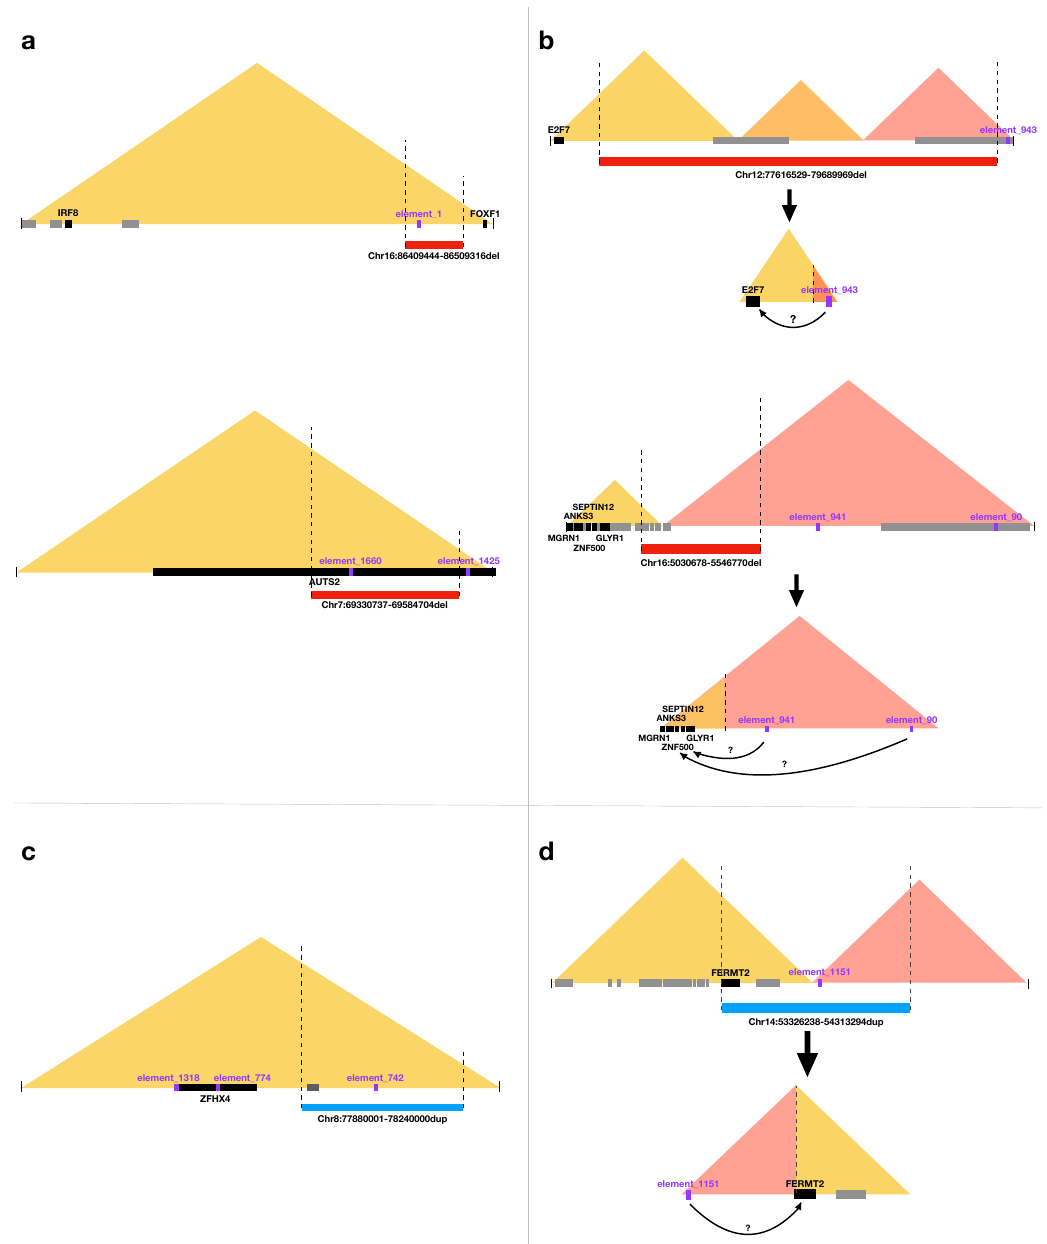
Figure 2. Schematic representation of the intraTAD deletions ( a ), interTAD deletions ( b ), intraTAD duplications ( c ), and interTAD duplications ( d ), potentially altering gene-enhancer interactions relevant for the congenital heart defects (CHD). The deletions are shown as red bars. The duplications are shown as blue bars. The triangles reflect the topologically associated domain (TAD) structure of the locus. CHD candidate protein-coding genes are depicted in black, other protein- coding genes within the TAD are depicted in grey, VISTA enhancer elements are depicted in purple. It is of note that only for VISTA element 1151 expression in the heart was confirmed (in transgenic mice at